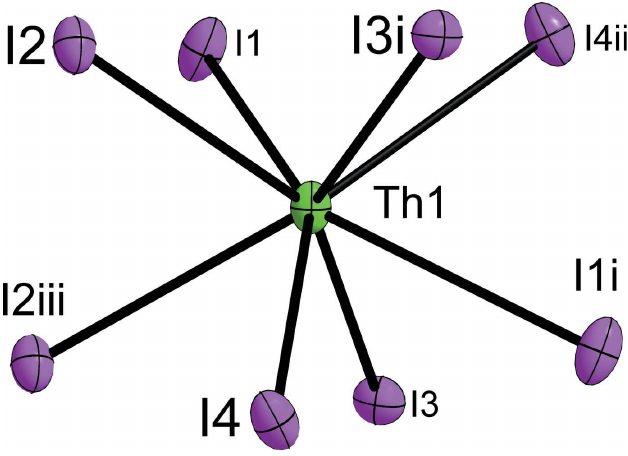
Figure 1 The irregular square-antiprismatic coordination sphere of the Th IV atom in the crystal structure of ThI 4 . Displacement ellipsoids are shown at the 95% probability level. [Symmetry codes: (i) x , y (cid:5) 1, z ; (ii) x , y (cid:5) 1, z (cid:5) 1; (cid:5) x , y (cid:5) 1 (cid:5) z ; (iv) (cid:5) x , (cid:5) y + 1, (cid:5) z + 1.] (iii) 1 , 1 2 2 2